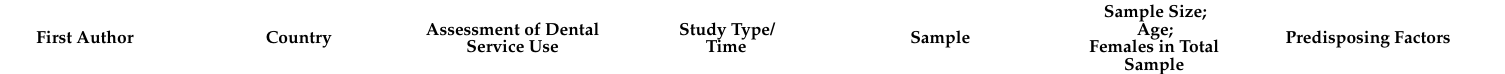
Table 2. Study overview and main findings (children and